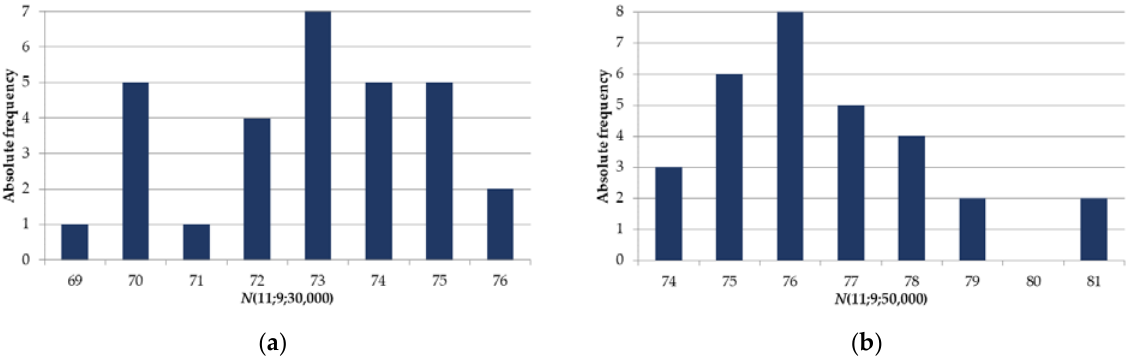
= 30,000; ) for: ( a ) N lim lim